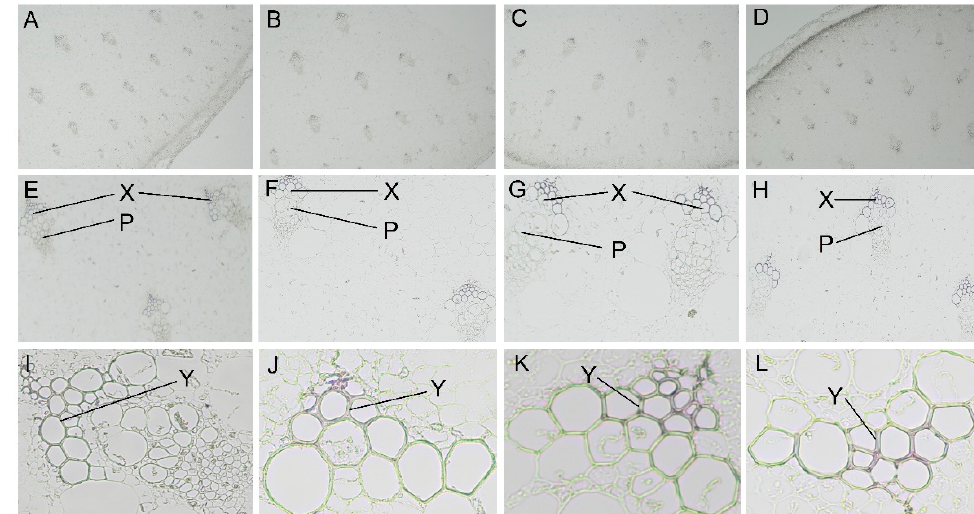
Figure 2. Lignin staining changes of asparagus under different shading treatments. ( A ) Full light × 40; ( B ) 35% shading × 40; ( C ) 55% shading × 40; ( D ) 75% shading × 40 ( E ) no shading × 100; ( F ) 35% shading × 100; ( G ) 55% shading × 100; ( H ) 75% shading × 100 ( I ) no shading × 400; ( J ) 35% shading × 400; ( K ) 55% shading × 400; ( L ) 75% shading × 400; (P) phloem; (X) xylem; (Y) cell walls ( × 40, × 100, and × 400 represent 40 × , 100 × , and 400 × microscope magnification,